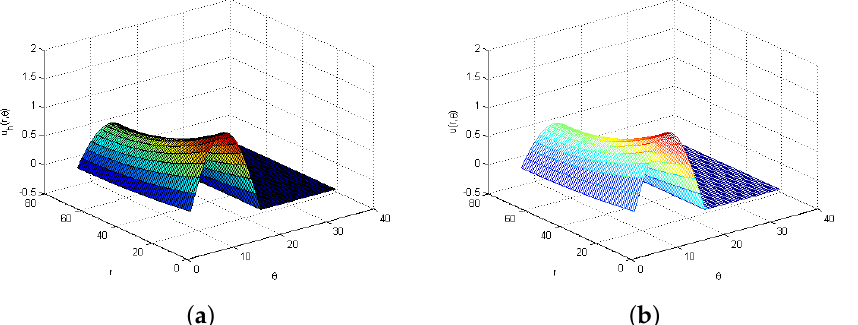
versus exact solution u ( a , c ), error u f h